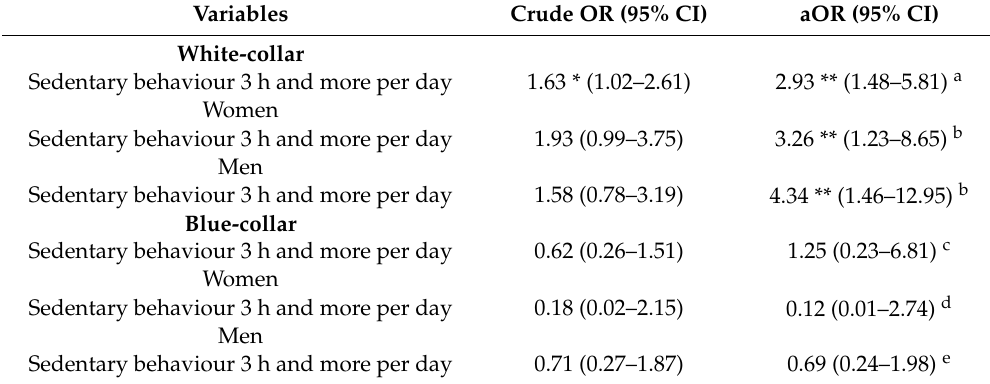
Table 3. Odds ratio for high perceived stress by hours of sedentary behaviour according to occupational groups and